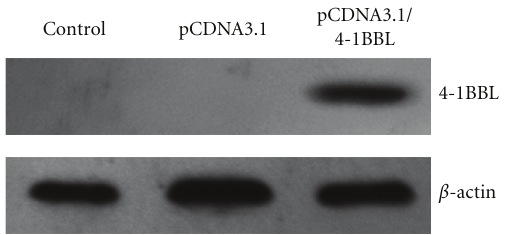
Figure 1: Total cell lysates were harvested, and presence of 4-1BBL protein was detected by anti-4-1BBL pAb. A specific band was identified in positive clone but not in RM-1 cells transfected with empty vector. β -actin was used as reference.